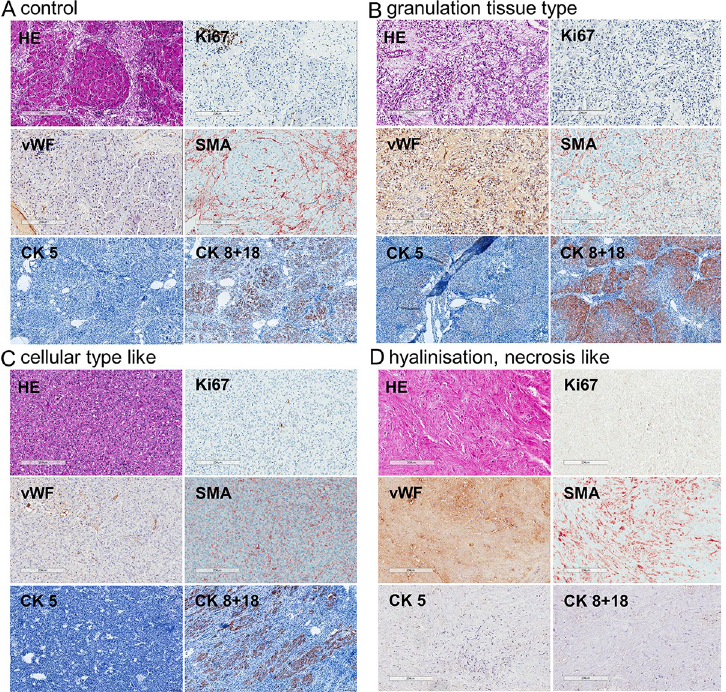
Fig 4. Histology of the different liver lesions. Representative images of treatment group 1 (15 mg/kg DENA weekly) are shown. A) Control, B) granulation tissue type, C) cellular type like, and D) hyalinization like. Ki67, van Willebrand factor (vWF), cytokeratin 8 and 18 (CK8+18), CK5, and alpha smooth muscle actin (SMA). Scale bars: 200 μ m or 100 μ m for CK5 and CK8+18 in A, B, and C.